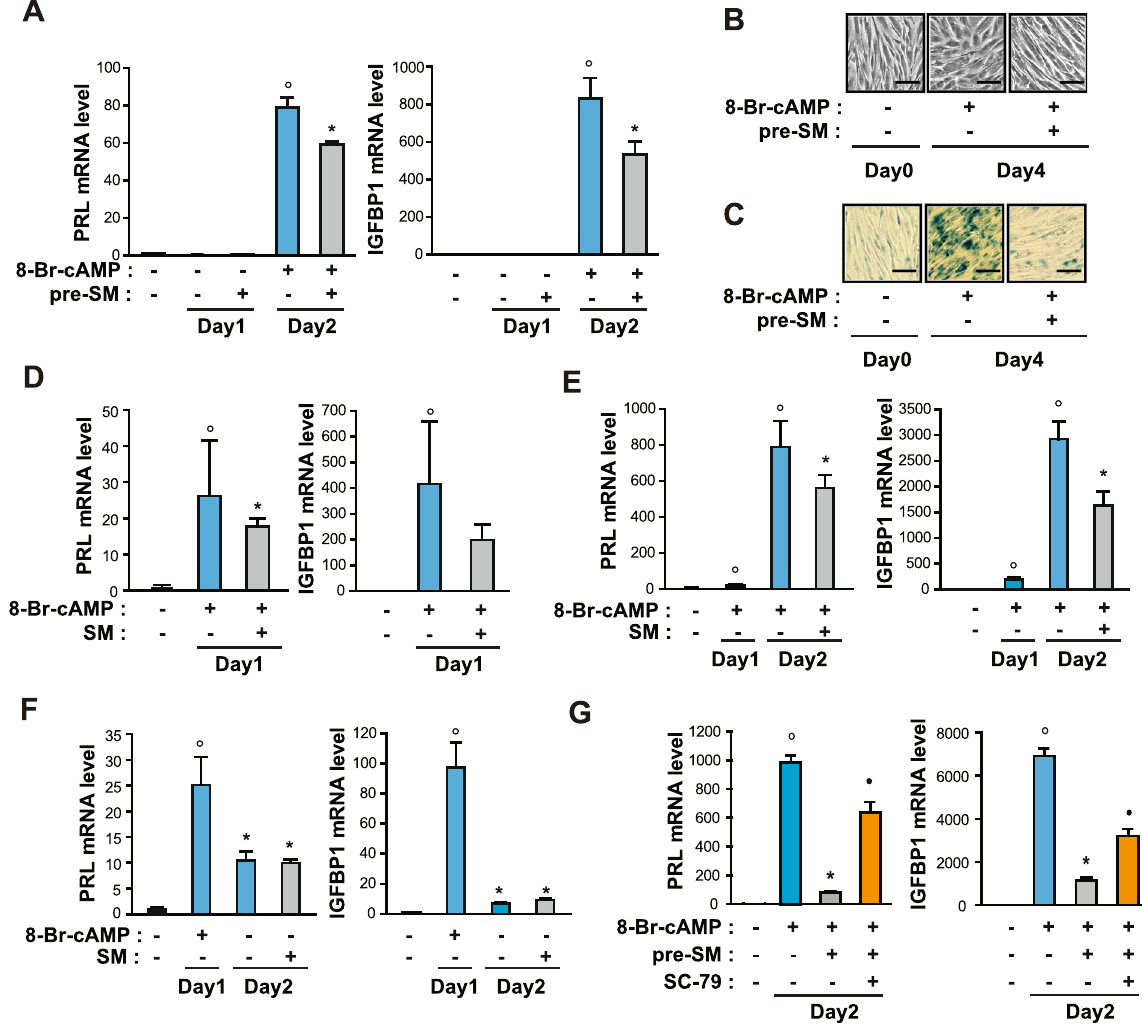
Figure 7. SM decreased decidualization of human eSCs. ( A ) Human eSCs were incubated either under 1 g or SM for 1 day, after which they were induced to differentiate in the presence of 0.5 mM 8-Br-cAMP under 1 g for 1 day. Cells were lysed and subjected to a quantitative real time PCR (qRT-PCR) analysis. ( B ) The cells were treated as in ( A ), induced to decidualization for 4 days, ( C ) stained using senescence associated β -galactosidase staining kit, and photographed under microscope. Scale bar = 50 μ m. ( D ) The cells were treated with 8-Br- cAMP under 1 g or SM for 1 day, lysed, and analyzed by qRT-PCR. ( E ) The cells were differentiated in the presence of 8-Br-cAMP for one day and shifted to either 1 g or SM for one day in the presence 8-Br-cAMP. The cells were then subjected to qRT-PCR. ( F ) The cells were differentiated as in ( D ) and shifted to either 1 g or SM for one day in the absence of 8-Br-cAMP. ( G ) The cells were incubated under SM with or without 5 μ g/ml SC-79 for 1 day, after which they were induced to differentiate in the presence of 8-Br-cAMP under 1 g for 1 day. The cells were lysed and subjected to a qRT-PCR analysis. Abbreviations: simulated microgravity (SM); simulated microgravity for 24 h before the induction of differentiation (Pre-SM); prolactin (PRL); insulin-like growth factor binding protein 1 (IGFBP1). Data are expressed as mean ± SD, with paired t -tests performed as indicated. ° P < 0.05 versus undifferentiated control; * P < 0.05 versus differentiated control without Pre-SM; • P < 0.05 versus differentiated cells with